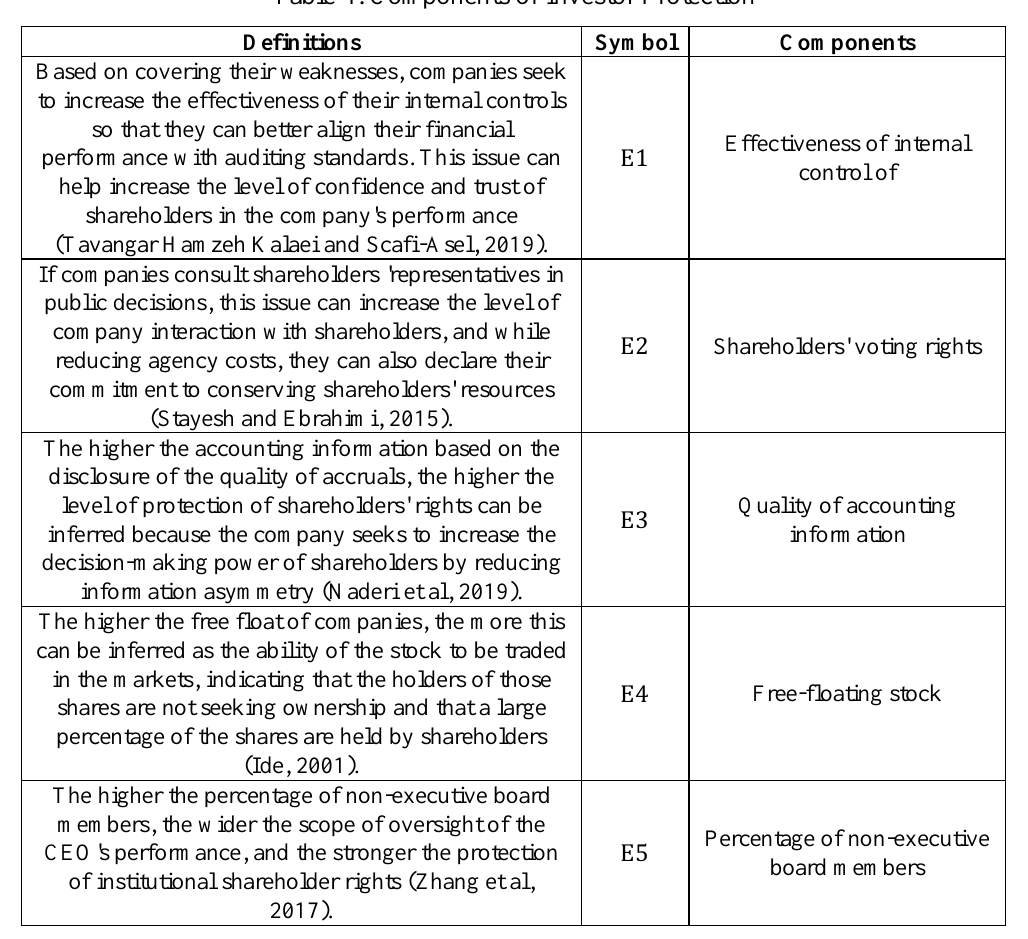
Table 4. Components of Investor